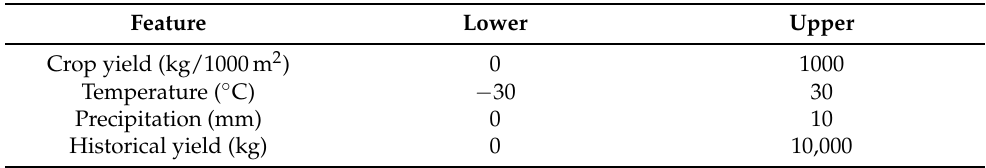
Table 2. The normalisation constants (lower and upper) used to scale feature values where min–max normalisation was not used. Feature